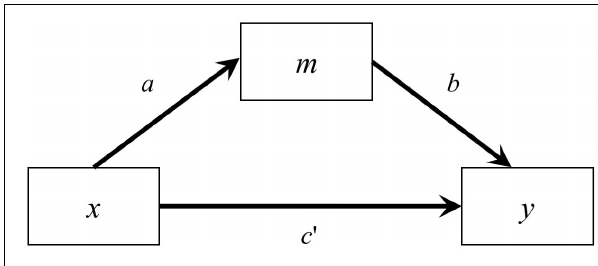
FIGURE 1 | A Simple Mediation